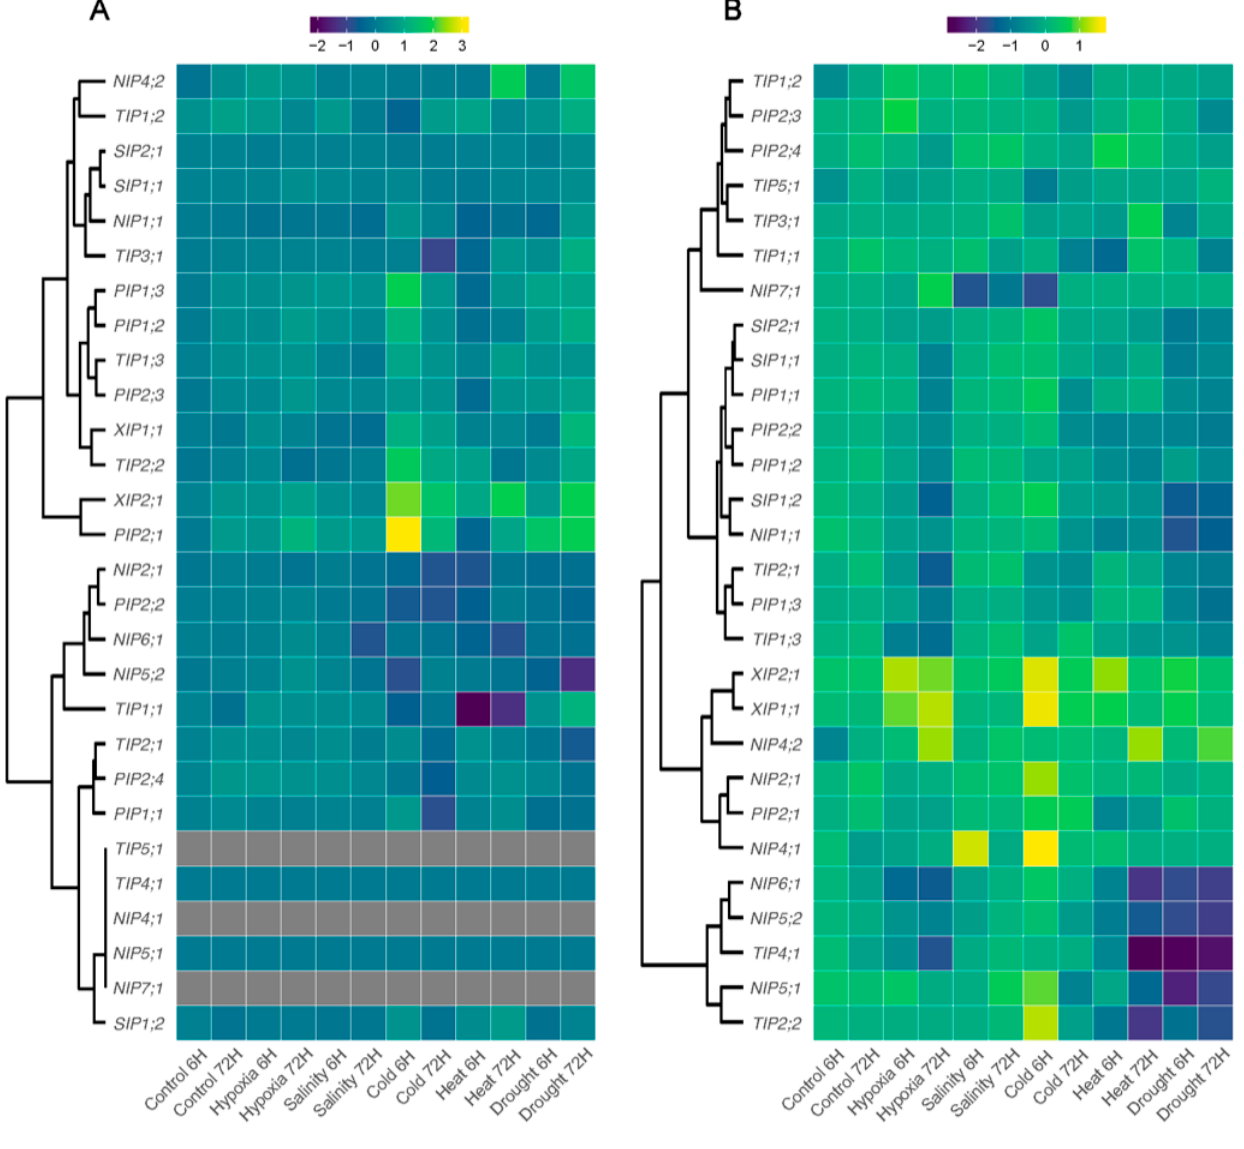
Figure 6. Heatmap and hierarchical clustering of the expression profiles of all AQP genes under different abiotic stress treatments. The expression abundance of each transcript (log2 of qPCR analysis fold-change values, three biological and two technical replicates) is represented by a color range from yellow (higher expression) to dark blue (lower expression). Gray: not detected transcript levels. For each AQP gene, transcript levels were calculated using its mRNA abundance detected in the control condition (6 h) as reference for the rest of the samples. ( A ) leaf, ( B ) root.